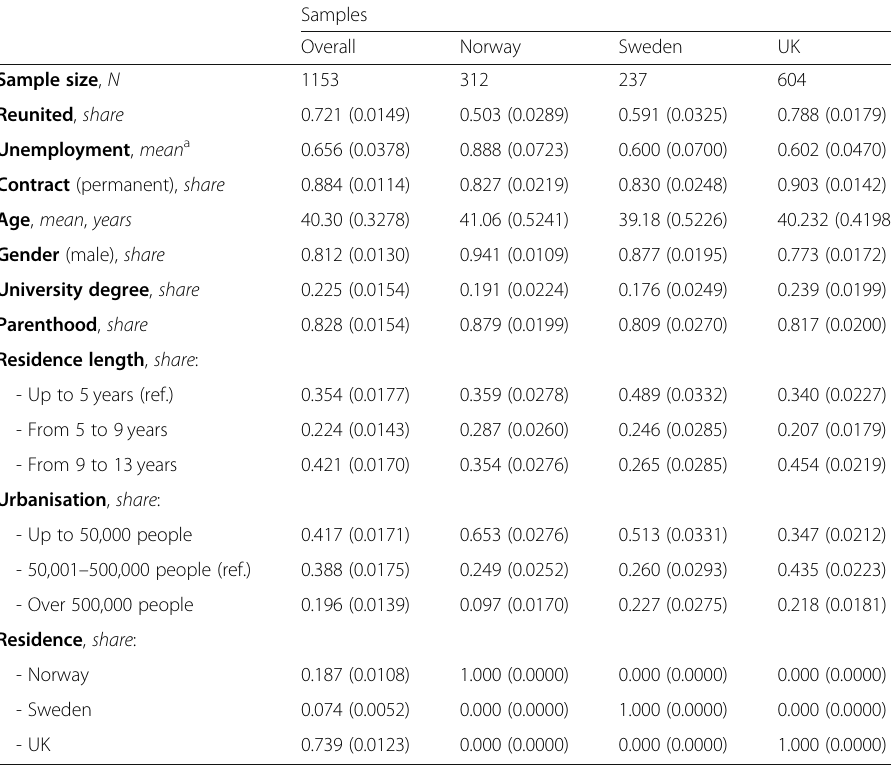
Table 4 Descriptive statistics of weighted samples, means/shares, and standard errors in brackets Samples Overall Norway Sweden